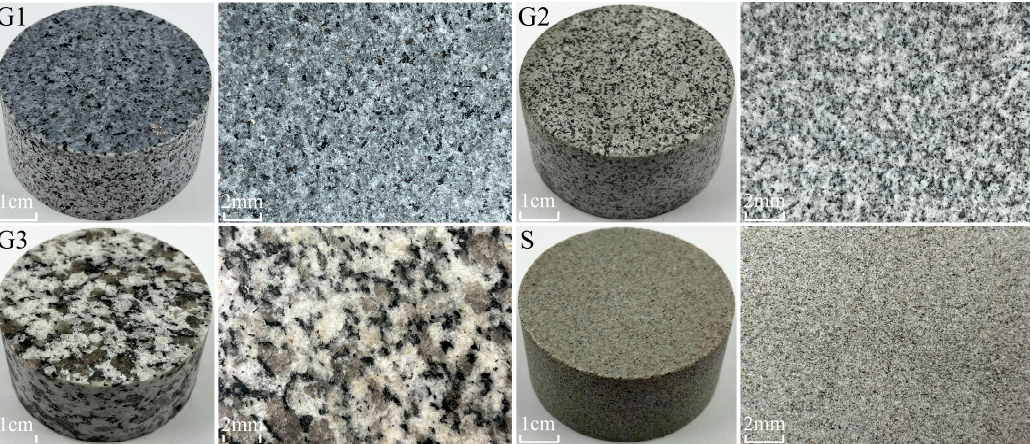
Figure 2. Photos and matrix surfaces of Brazilian disc specimens of the lithologies G1, G2, G3, and S.